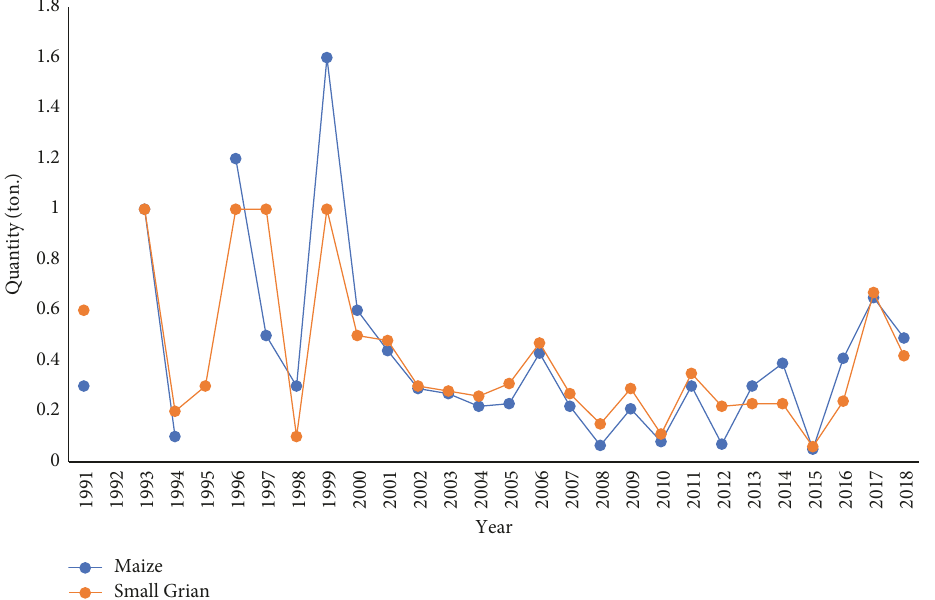
Figure 2: Crop production trends in Chiredzi District from 1991 to 2018. Source: AGRITEX Department—Chiredzi District.